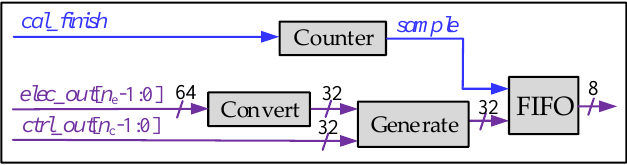
Figure 6. The FPGA-based real-time simulator for active distribution networks. When a case is modified online, the file storing the information of the case is downloaded to the FPGA via the USB interface. The simulation results are uploaded to the host PC via Ethernet interface